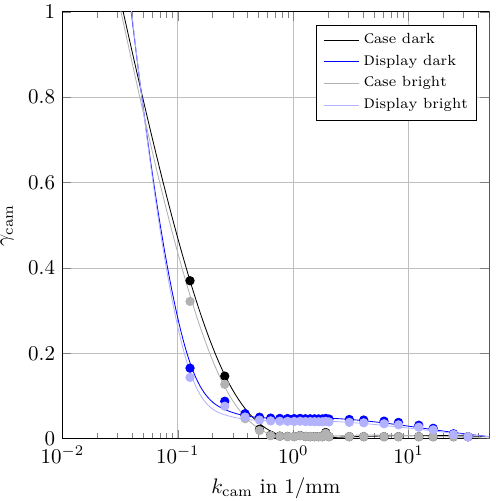
Figure 21. Measurements of the surface MTF (points) and extrap- olated data (lines) for two areas on the surface (display and case) and two illumination conditions (dark and bright surrounding).